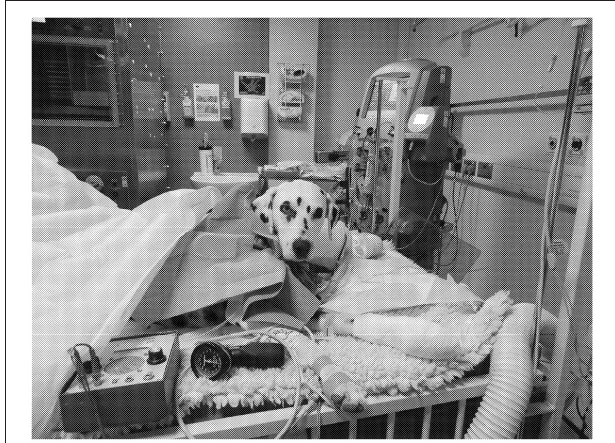
FIGURE 1 | Patient undergoing a plasma exchange (PEX) cycle. Permission for publication of this image was obtained by the clients. In the background, the extracorporeal plasma filtration unit can be seen (Prismaflex ® ;Gambro).